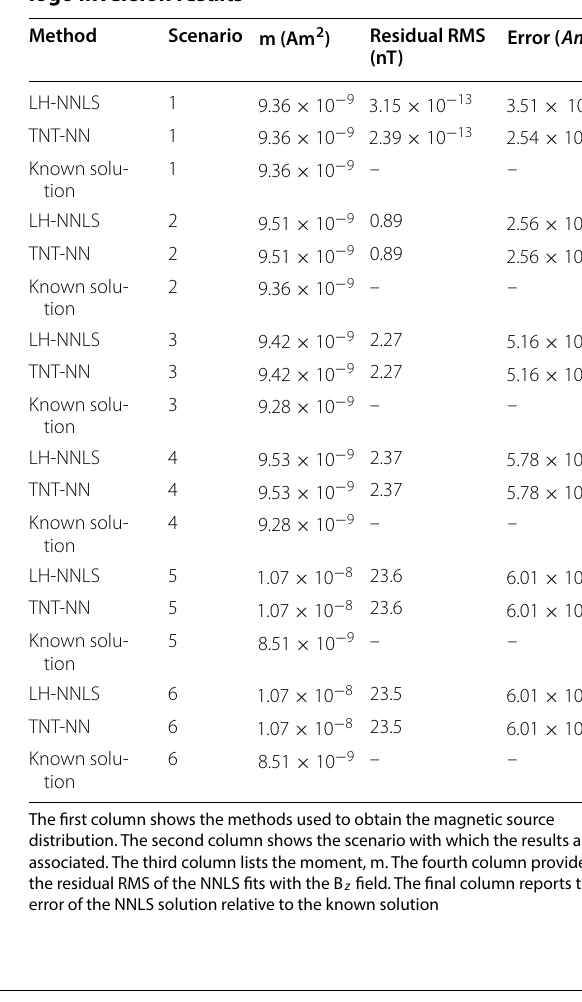
Table 1 Summary of the unidirectional synthetic